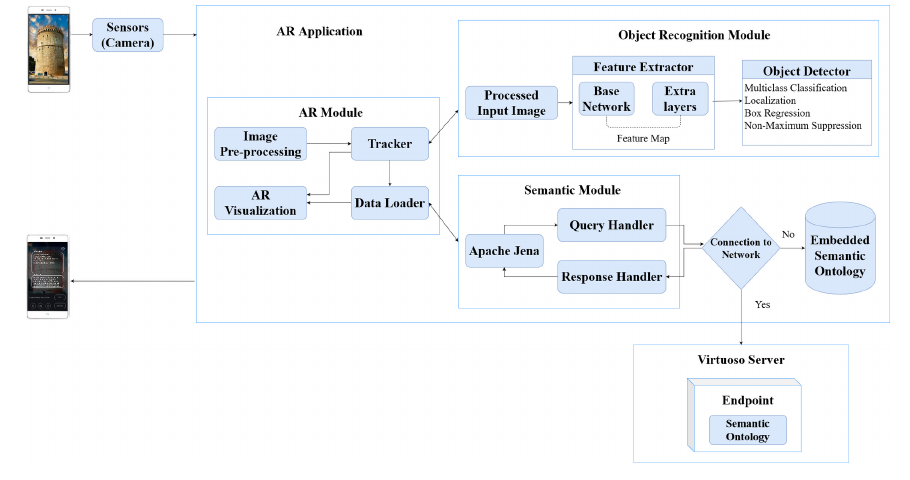
Fig. 3. Application